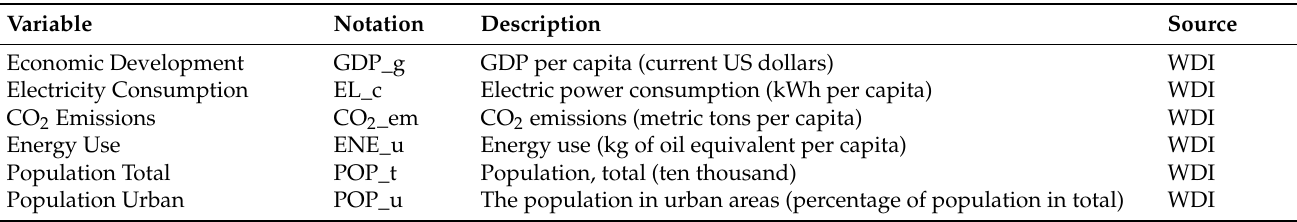
Table 1. Data and the sources for China,